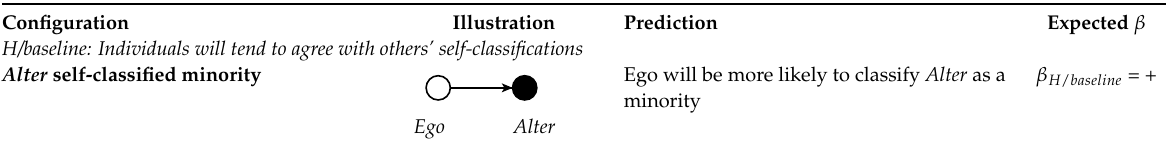
Table 1: Configurations tested in the model.